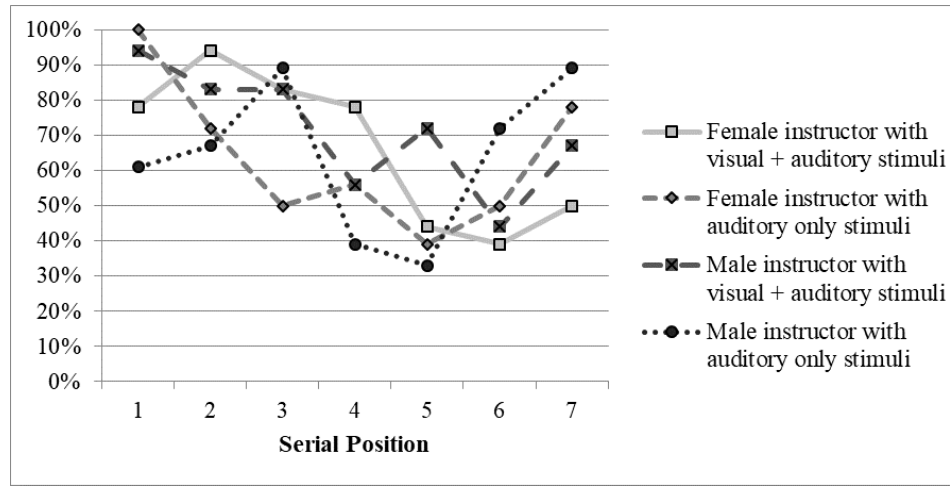
Percentage correct mean responses by serial position for neuro-typical university